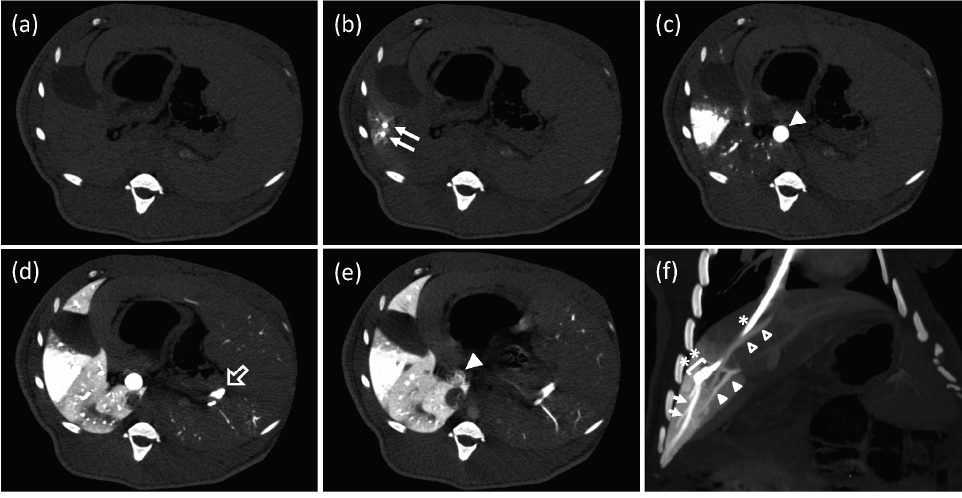
Figure 2. Computed tomography (CT) study during a hydrodynamic injection from a